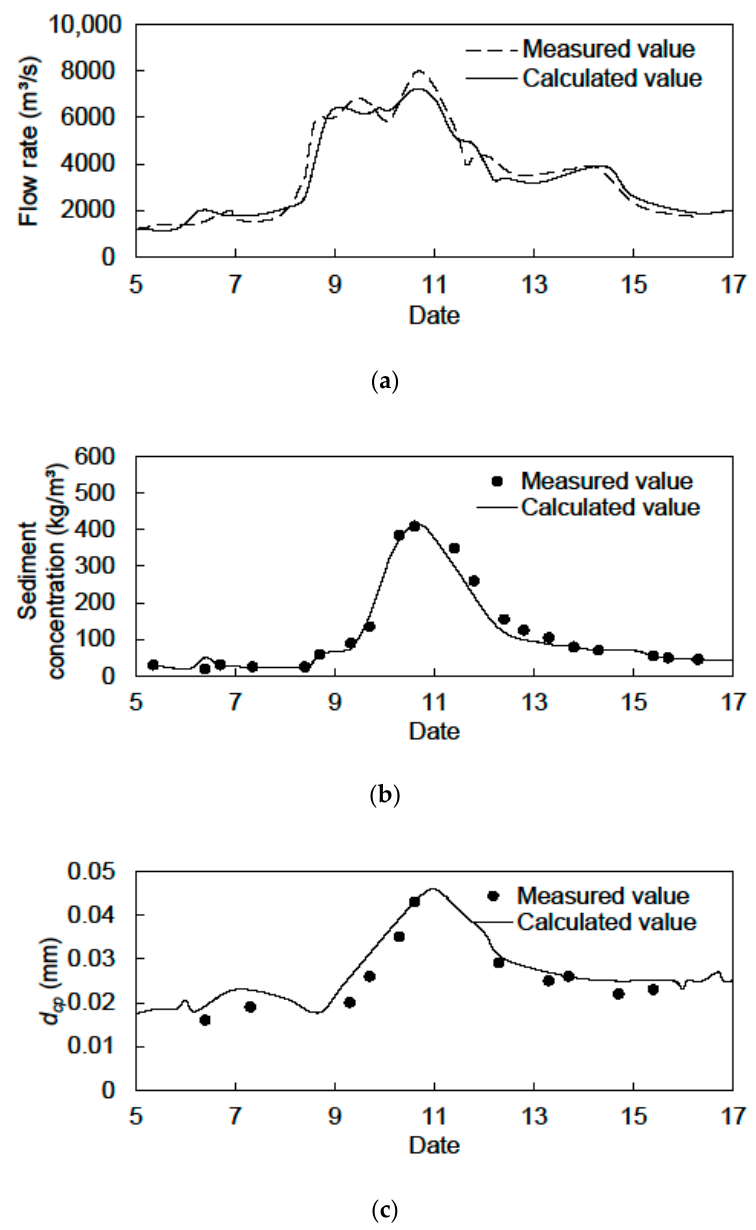
Figure 7. Verification results of water and sediment processes based on data from Jiahetan station in July 1977. ( a ) flow rate; ( b ) sediment concentration; and ( c ) d cp .